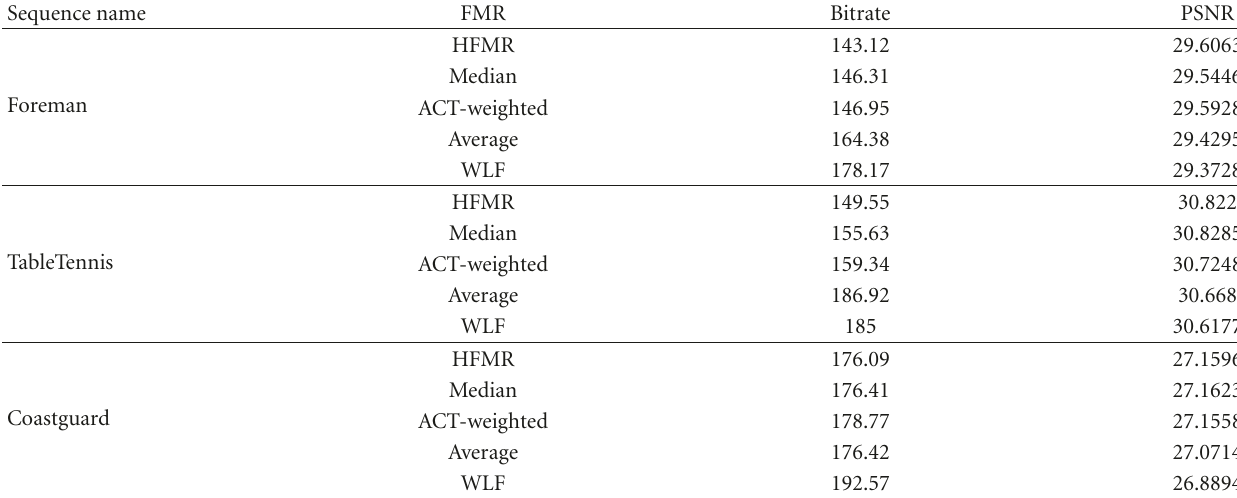
Table 3: Experimental results for three simulated sequences at QP = 10.